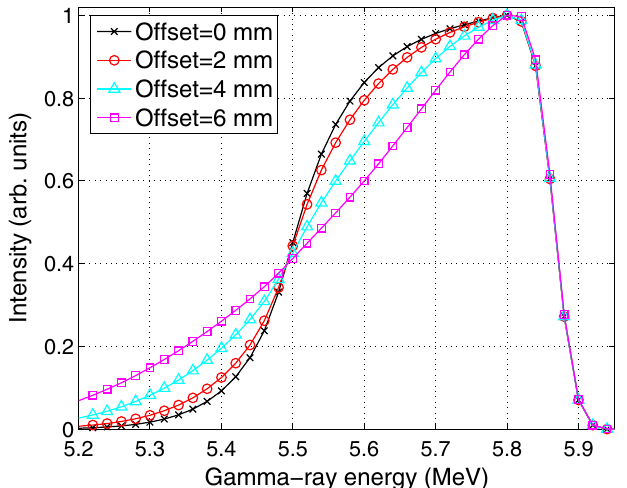
FIG. 5. (Color) Calculated energy spectra of gamma beams produced by Compton scattering of a 800 nm laser beam with a 500 MeV electron beam for different alignment offsets of the collimator. The collimator with an aperture radius of 16 mm is placed 60 m downstream from the collision point. The electron beam energy spread and horizontal emittance are fixed to 2 (cid:1) 10 (cid:2) 3 and 10 nm rad, respectively. The spectra are scaled to their respective peak